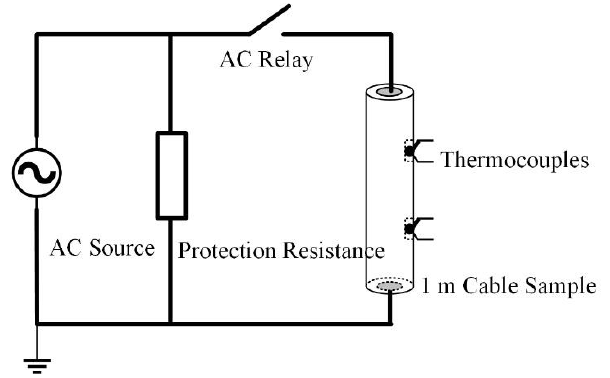
Figure 8. Circuit diagram of cable shielding current experiment.